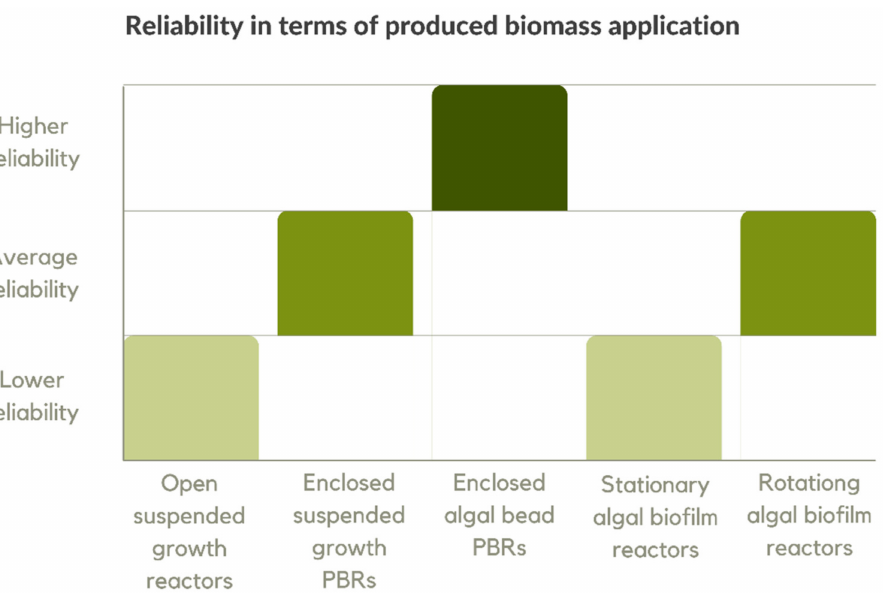
Figure 11. Reliability of the available algae-based wastewater treatment reactor configurations in terms of safe excess algal biomass